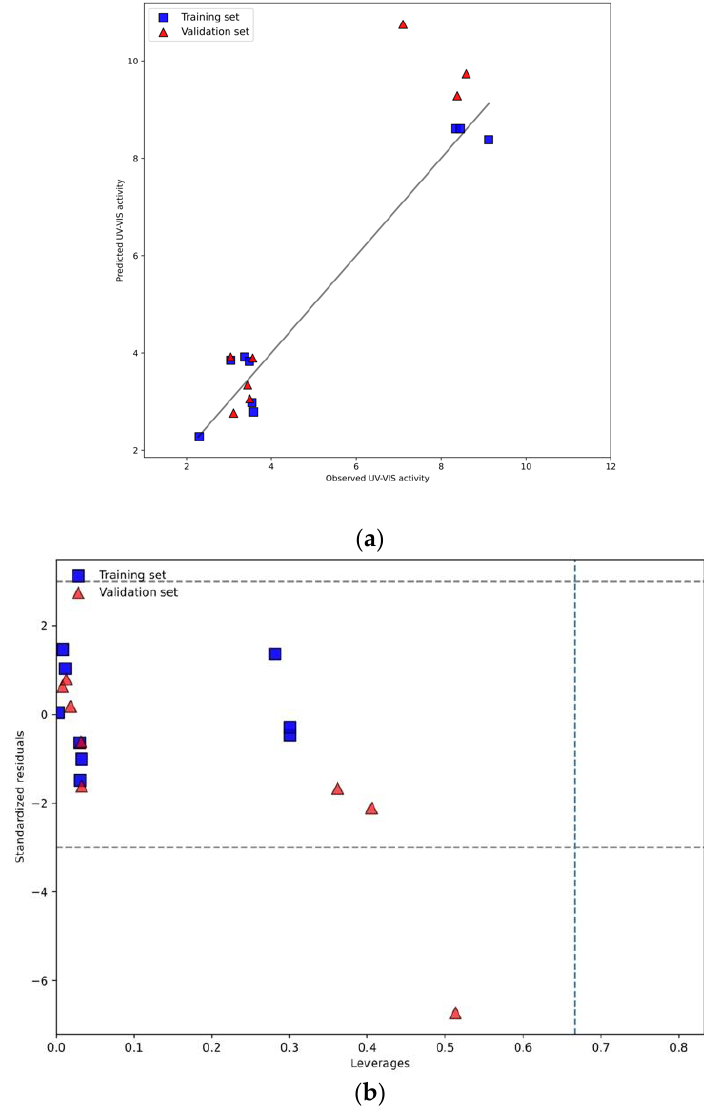
Figure 6. ( a ) Observed vs. predicted diagram for developed MLR-GA ( b ) Applicability domain represented by Williams plot.